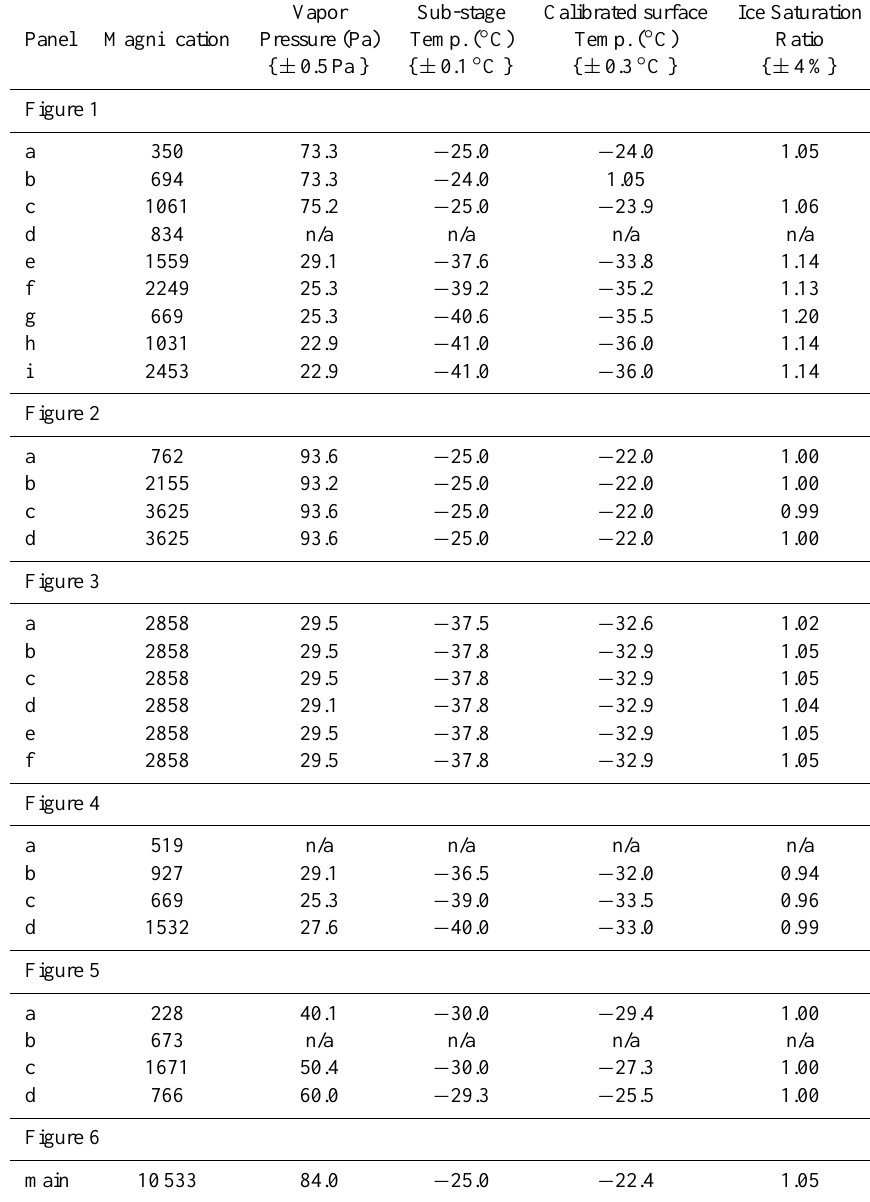
Table A1. Magnification, temperature, vapor pressure, and calculated saturation ratios for images in